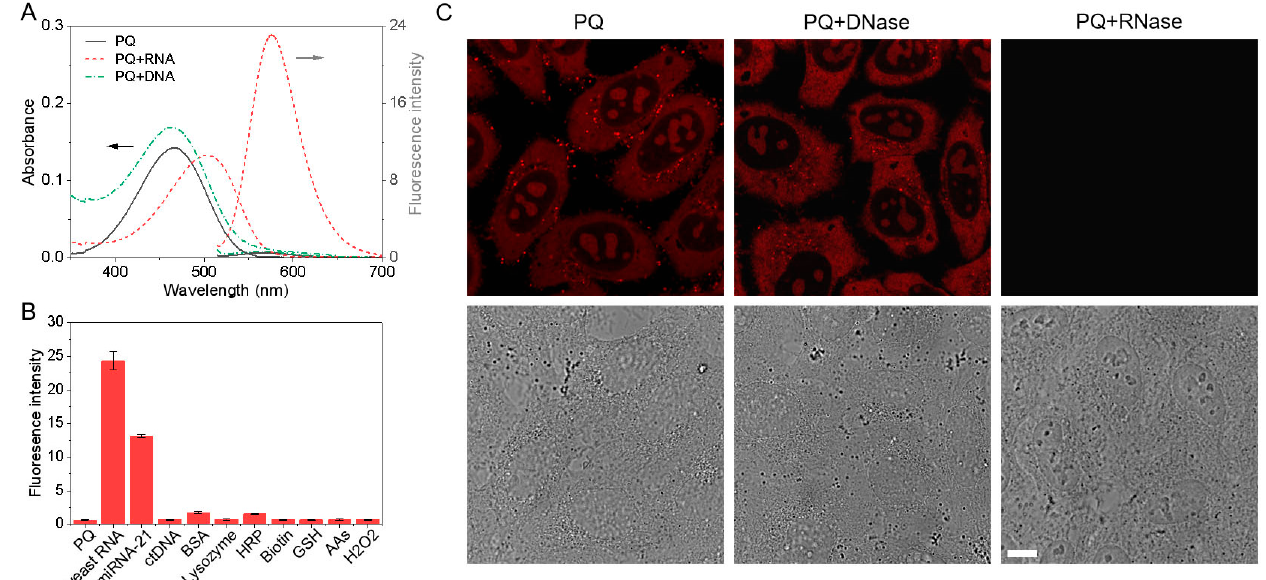
Figure 3. RNA selectivity. ( A ) UV–vis absorption and fluorescence spectra of 5 µM PQ in the presence of RNA/DNA. The black arrow means “using the left coordinate axis”, and the grey arrow means “using the right coordinate axis”; ( B ) Fluorescence comparison of 5 µM PQ in the presence of yeast RNA (1.0 mM phosphate), miRNA-21 (48 µM phosphate), ct DNA (1.0 mM phosphate), proteins (1.0 mg/mL), biotin (10 mM), glutathione (GSH, 10 mM), amino acids (10 mM) and H 2 O 2 (10 mM)